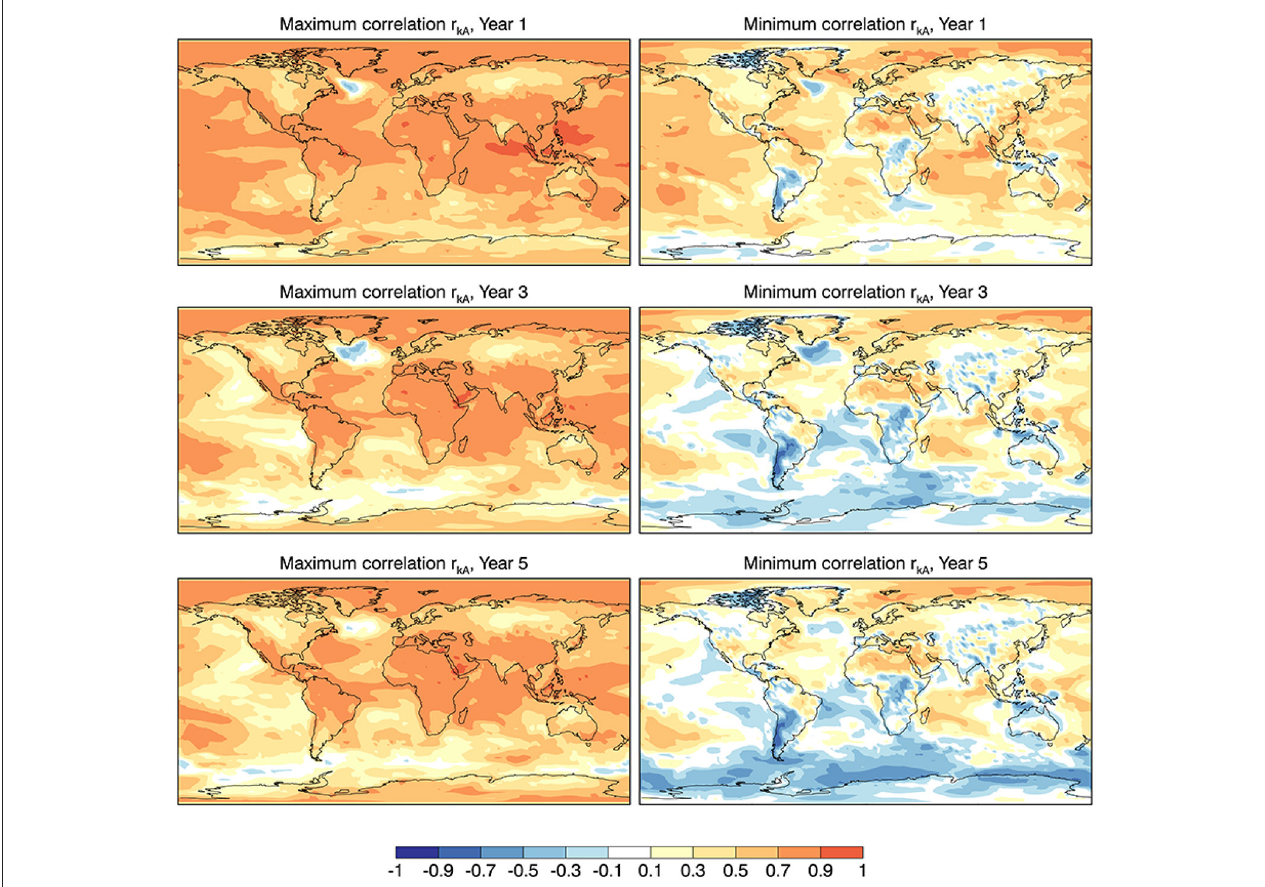
FIGURE 8 | The local maximum and minimum correlation skill r kA over all reanalysis for Year 1, 3, and 5 ensemble mean